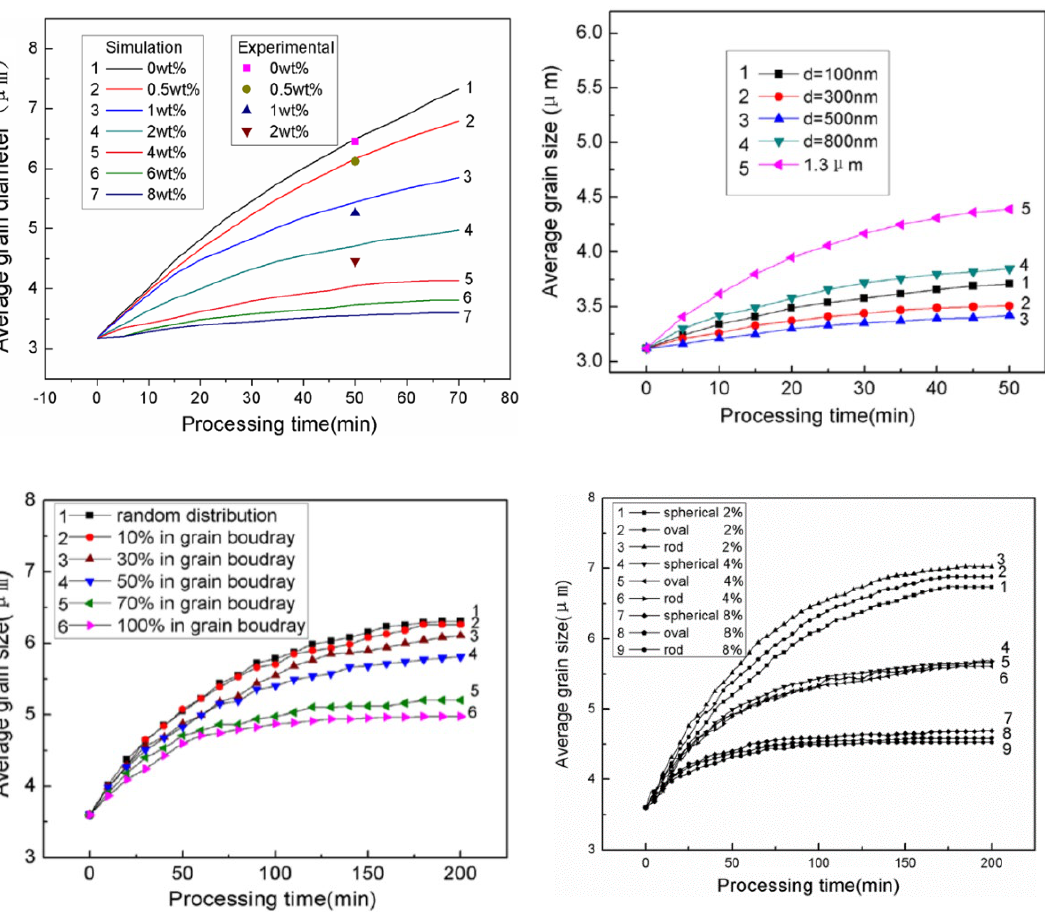
Figure 17. Simulated changes in the average grain size of AZ31 alloy versus processing time for different fraction, size, distribution, and shape of second-phase particles at 623 K [118].